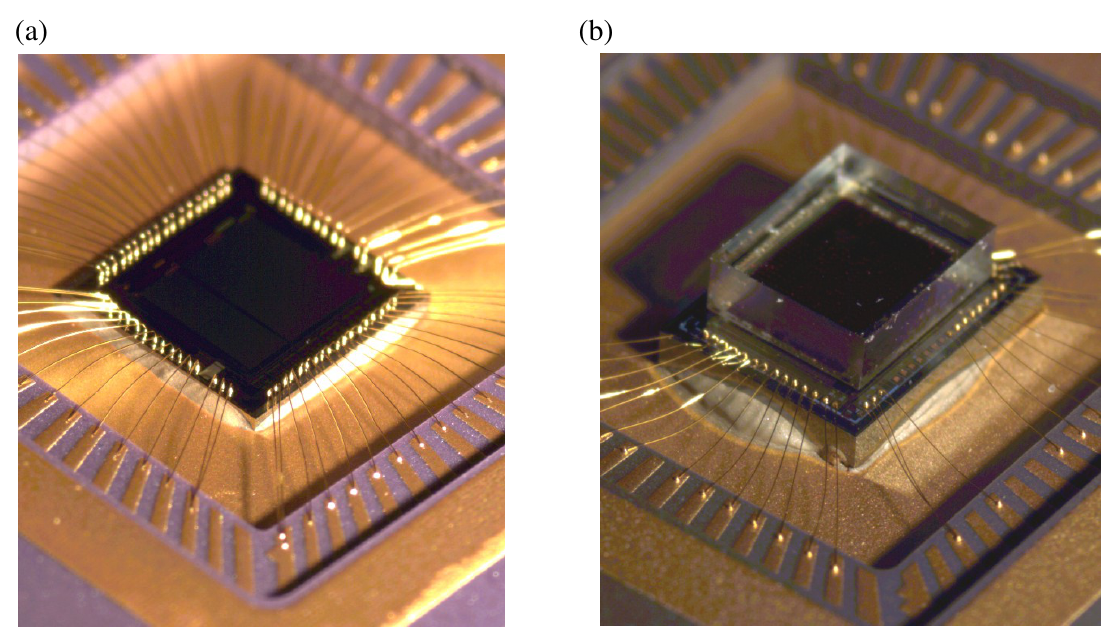
Figure 1. (a) CMOS and (b) VI-CMOS image sensors designed at the University of Alberta and fabricated via CMC